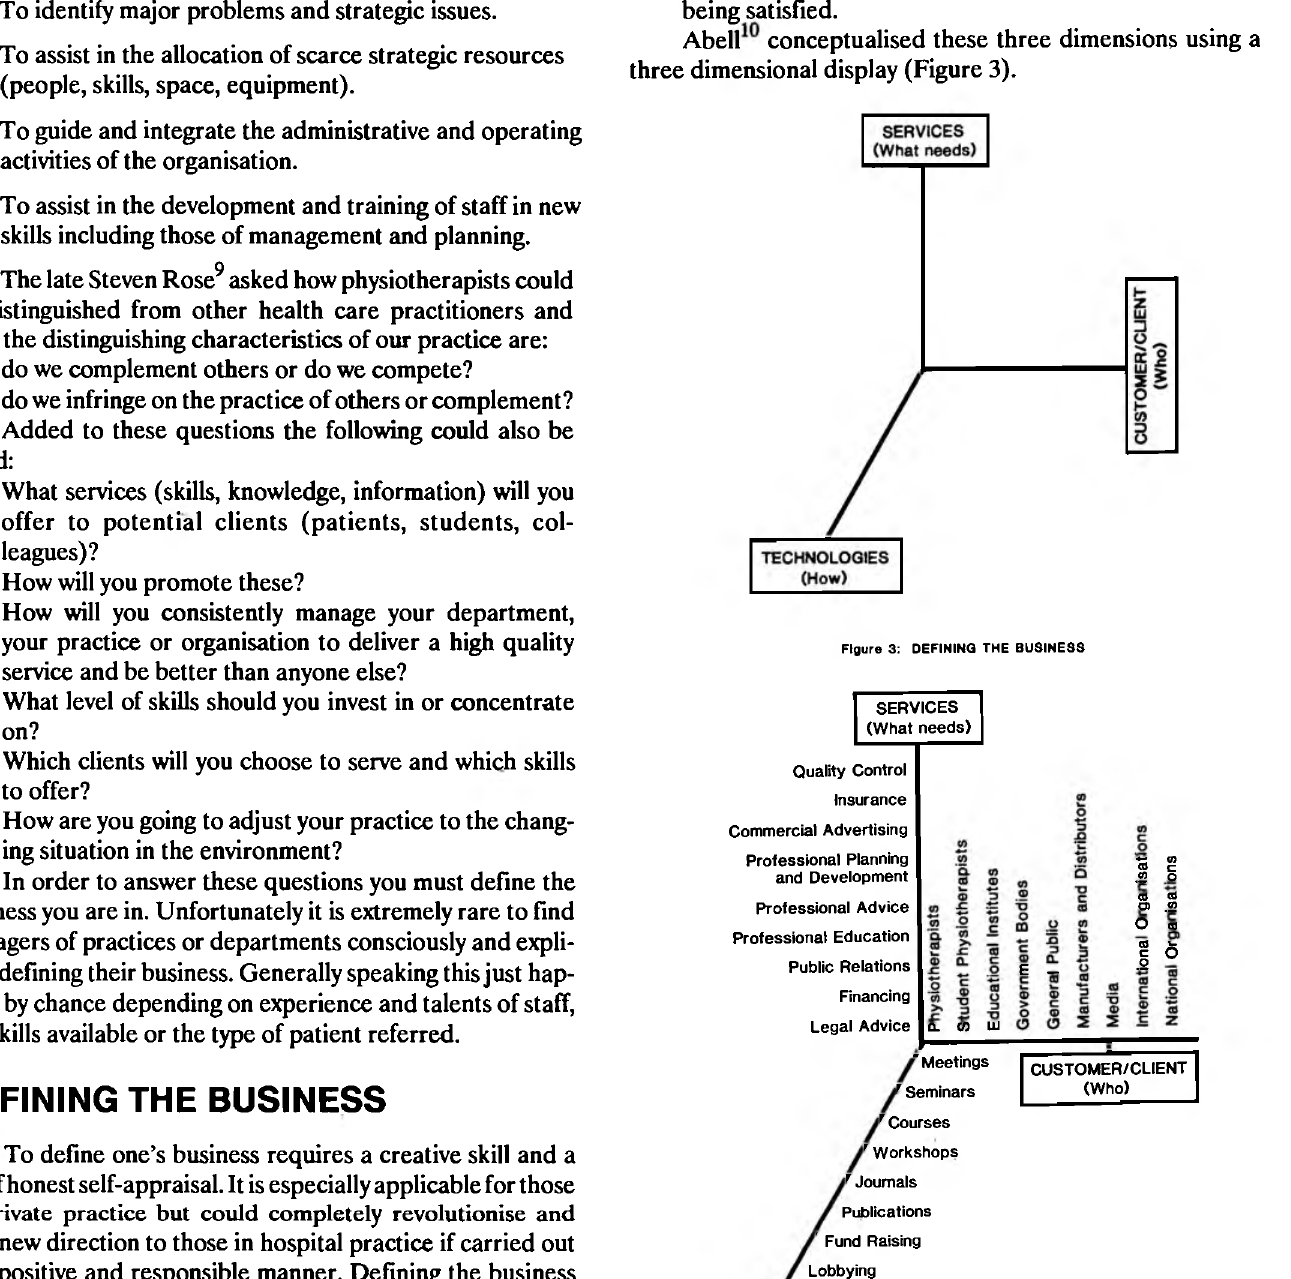
SERVICES (What needs)